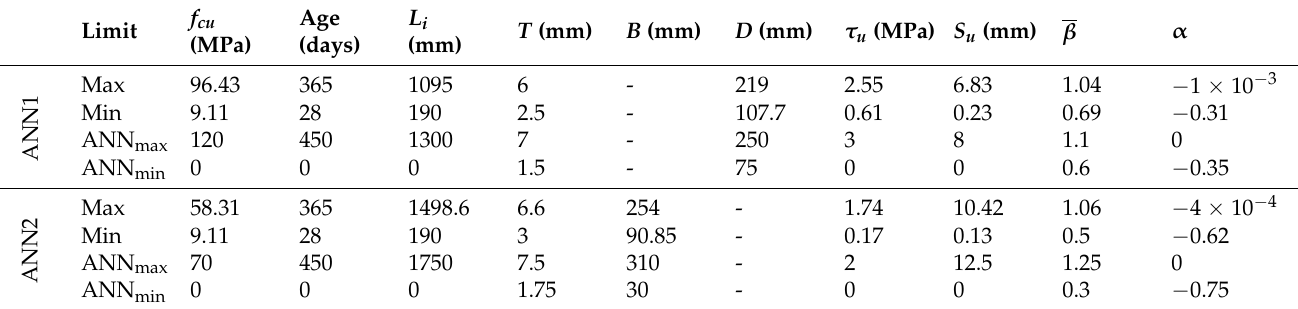
Table 2. Utilized datasets’ maximum, minimum, ANN max , and ANN min